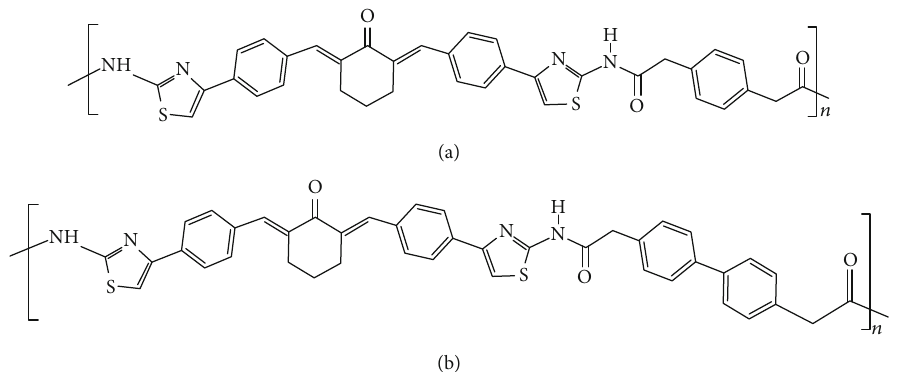
Figure 5: Copolymer of bis(2-aminothiazol-4-ylbenzylidene) cyclohexanone and (a) terephthaloyl chloride and (b) biphenyldicarbonyl